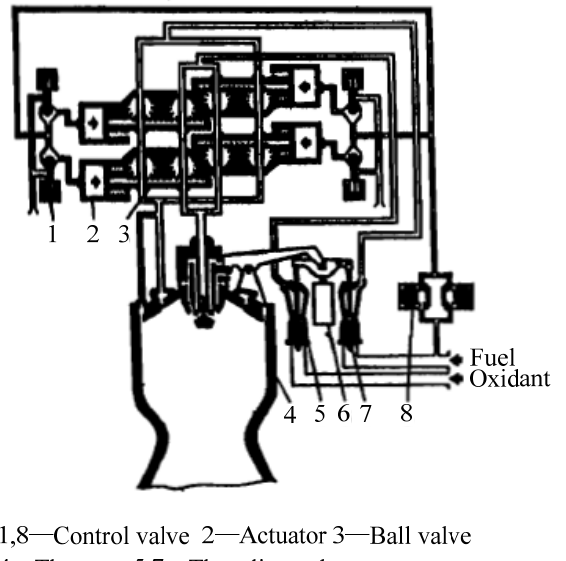
Figure 1. Working schematic of a mechanical positioning scheme of an MIRA-10K series